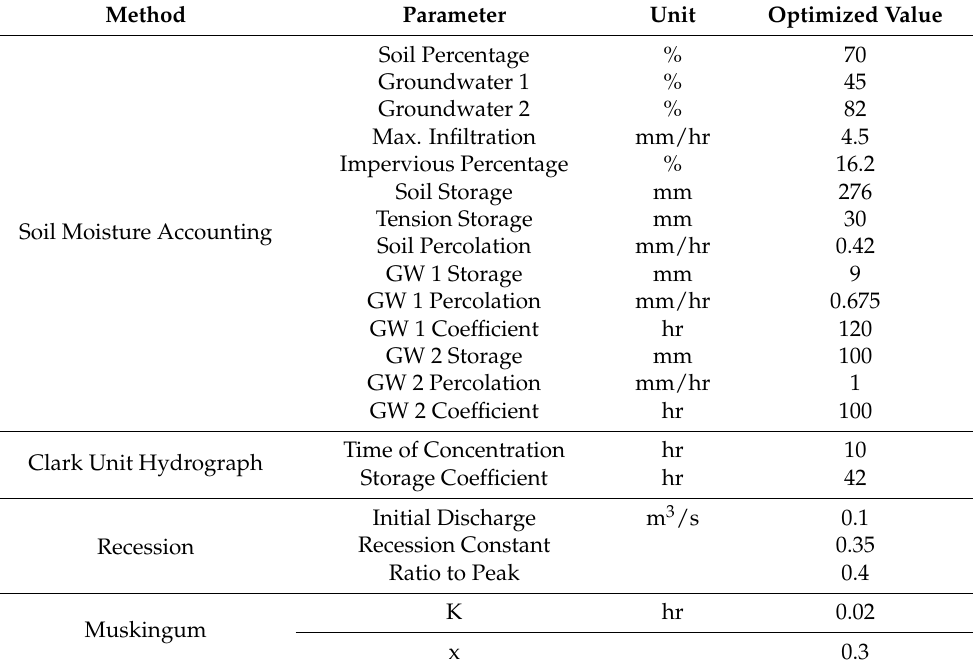
Figure 4. Comparison of daily observed and simulated streamflows at kh.92 for the 2007–2014 period from the HEC-HMS model. Table 1. Optimized parameters of HEC-HMS model.